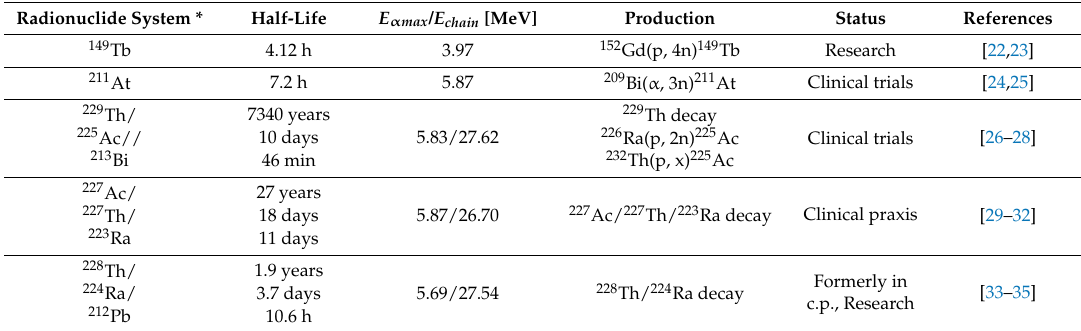
Table 1. Summary and properties of the most relevant alpha particle emitters suitable for nuclear medicine